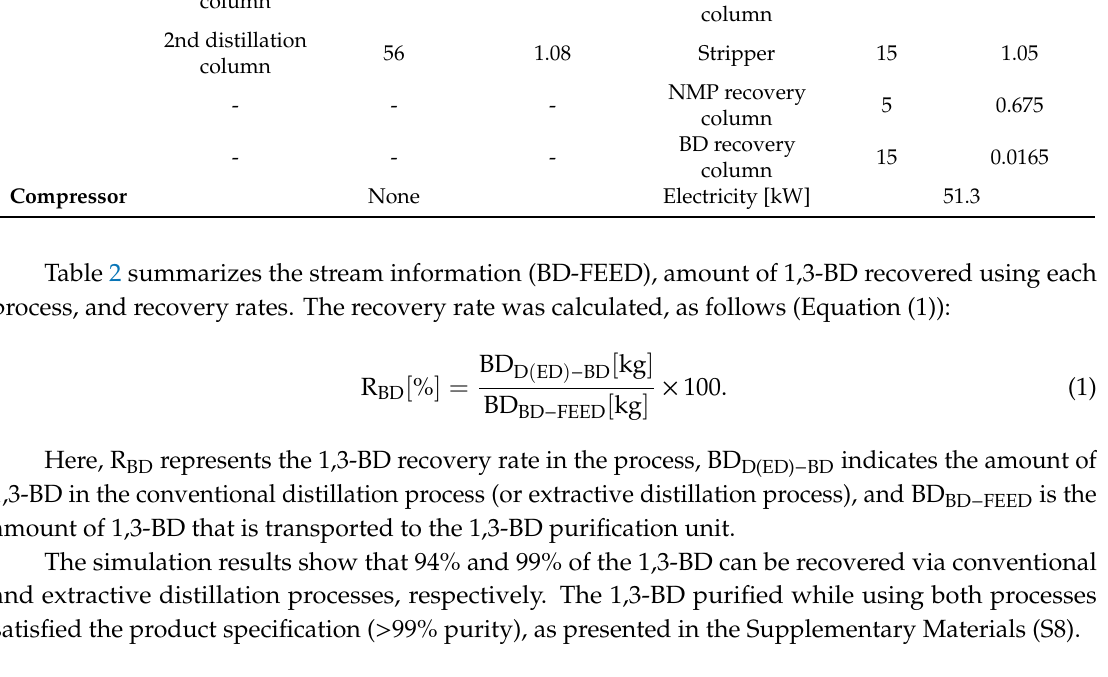
Table 2. Performance comparison of the distillation and extractive distillation